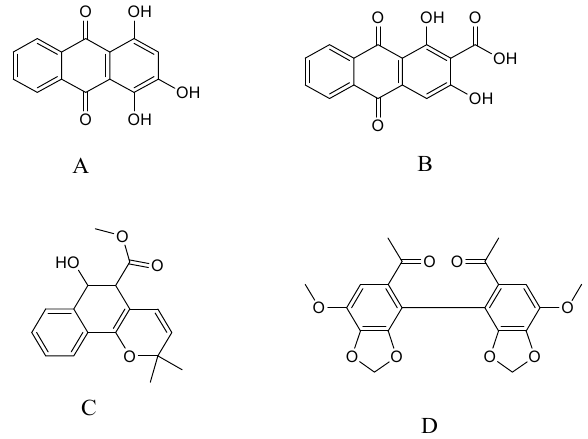
Figure 1. Chemical structures of purpurin ( A ); munjistin ( B ); mollugin ( C ); and I.S. ( D ).